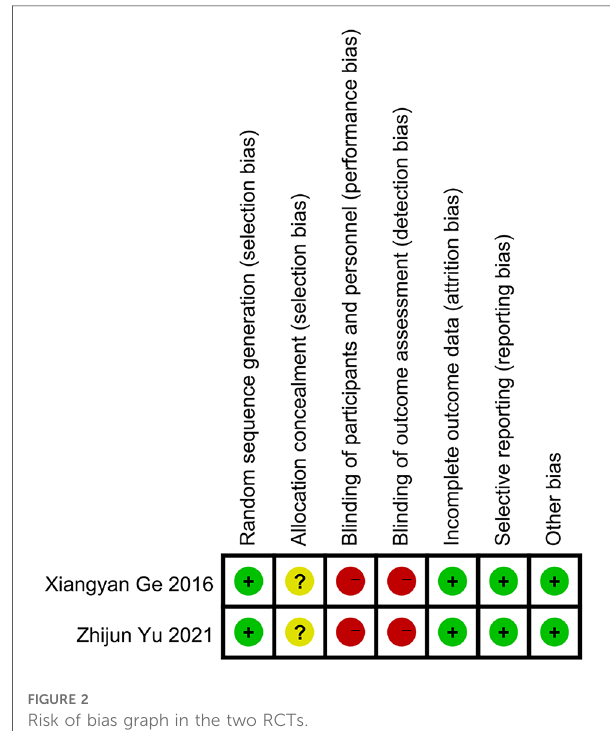
FIGURE 2 Risk of bias graph in the two RCTs.